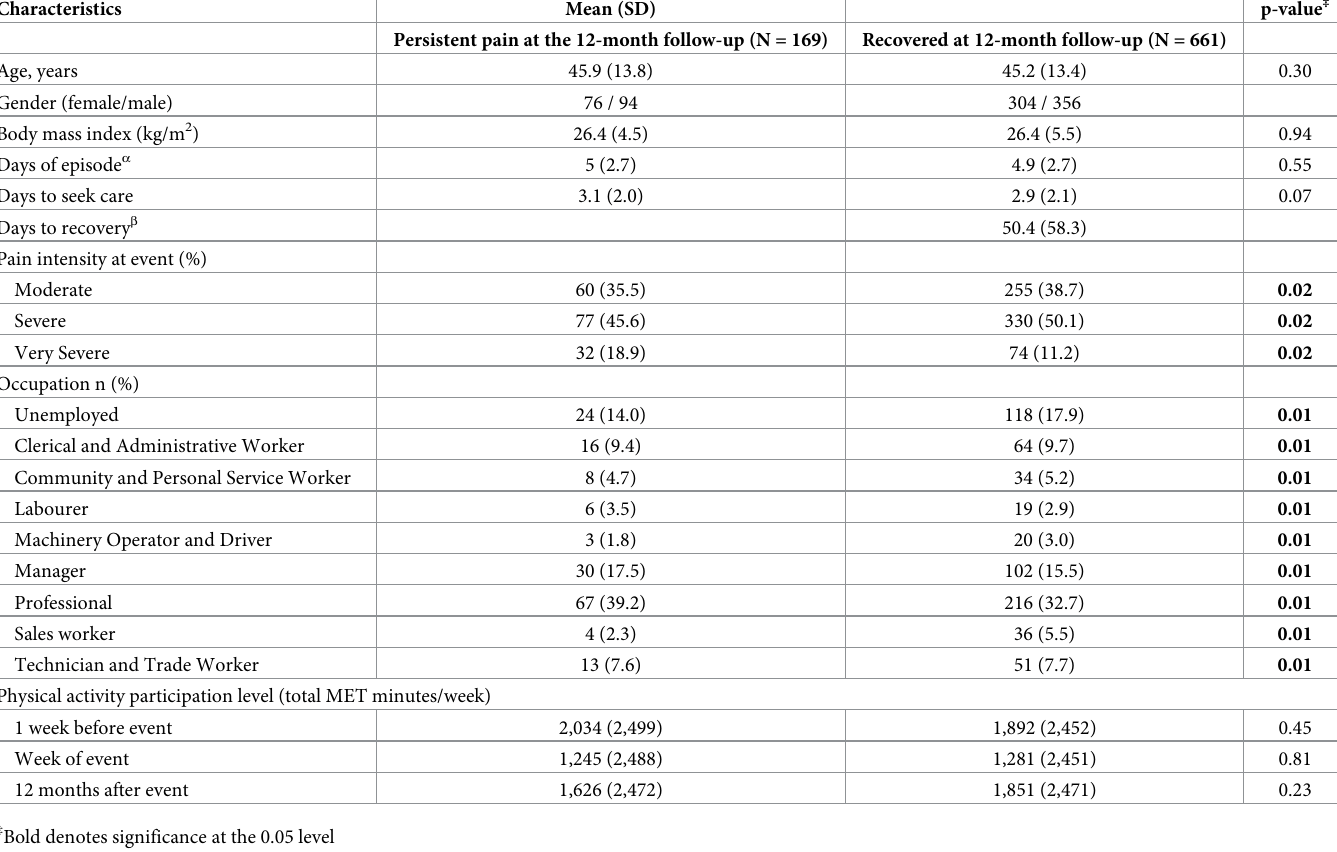
Table 1. Baseline characteristics of the participants presented as mean (standard deviation), unless otherwise stated. Characteristics